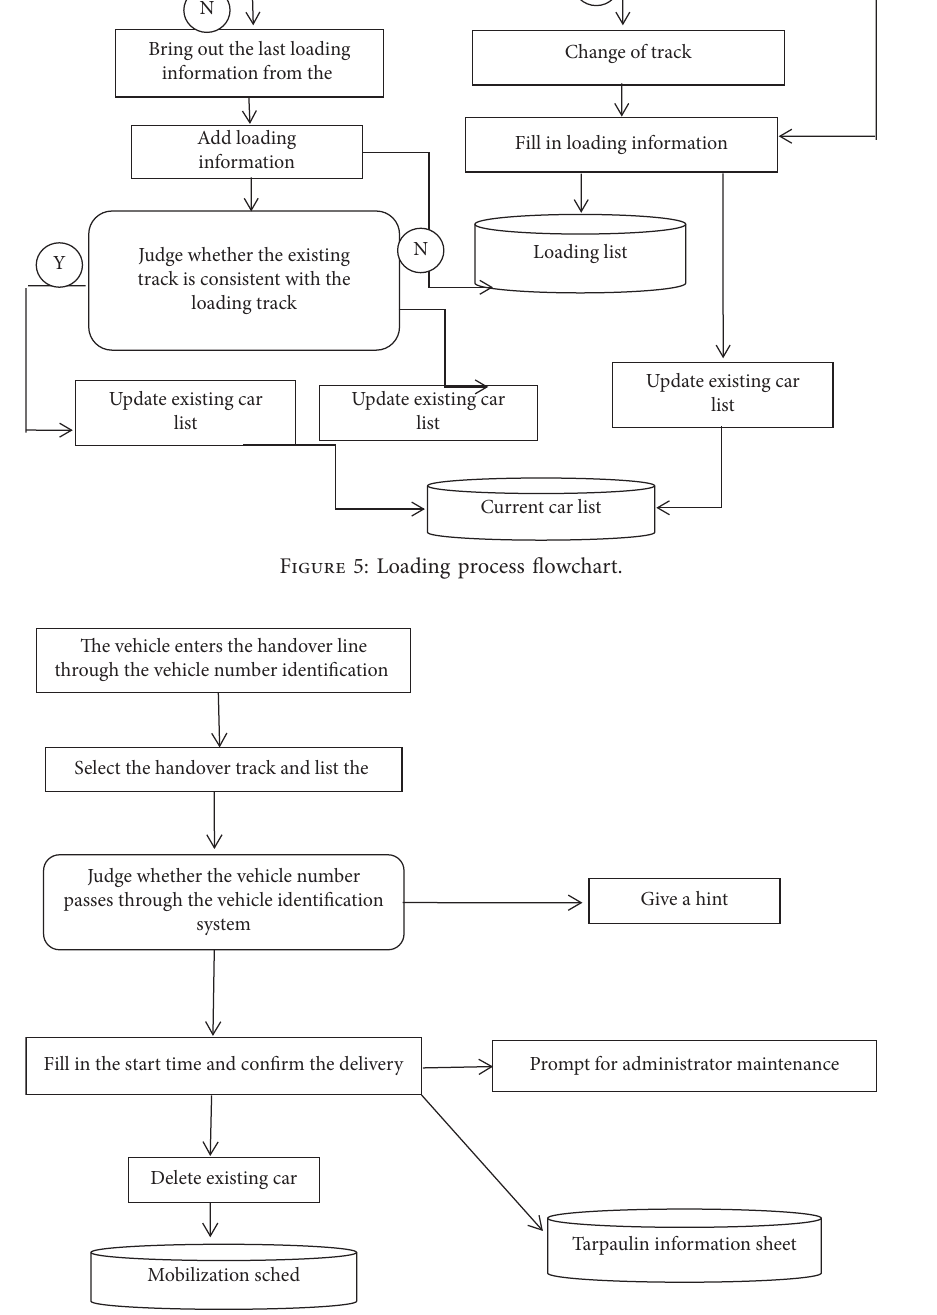
Figure 6: Flowchart of train number delivery